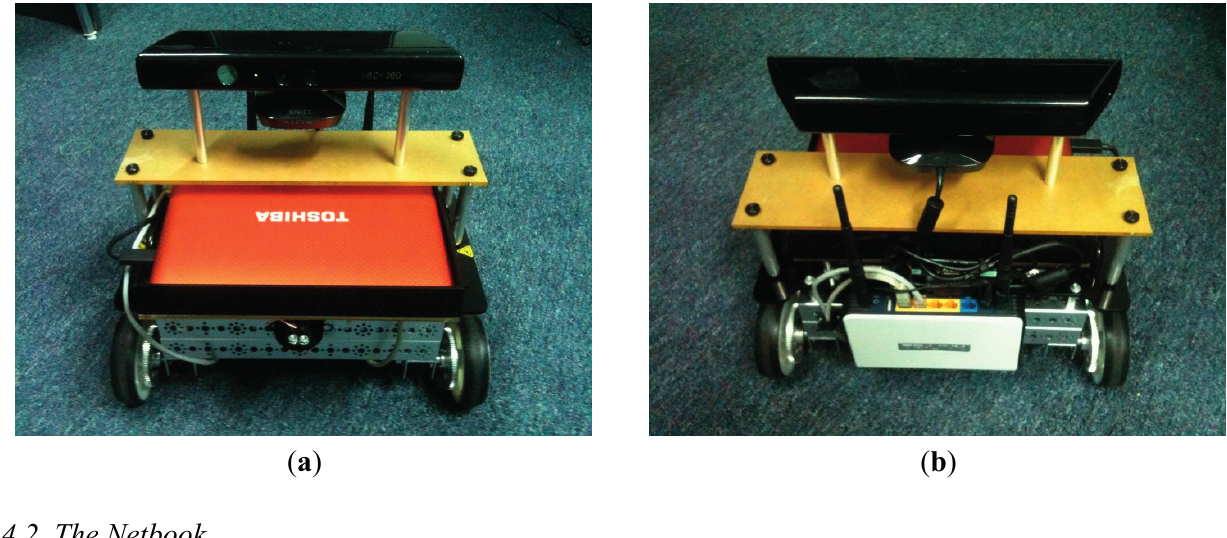
Figure 3. ( a ) Front and ( b ) rear view of the integrated